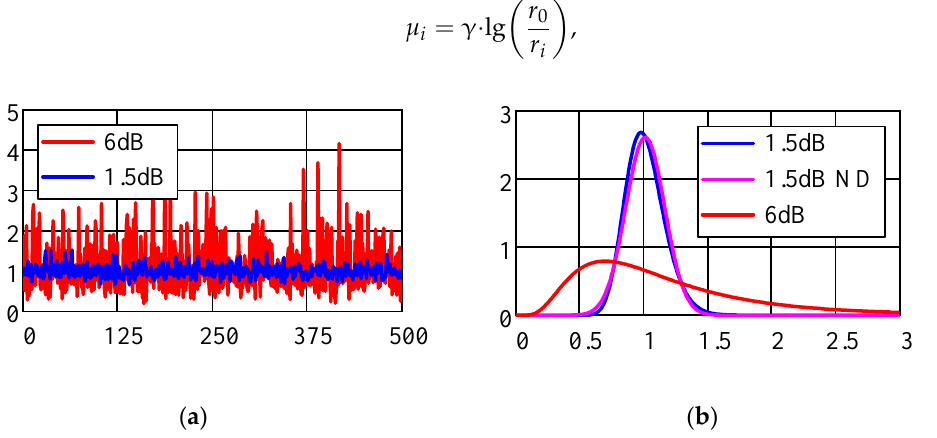
Figure 2. Change in the amplitude of the UWB signal ( a ) and the probability distribution density of the amplitude ( b ) for different values of the parameter σ P of the lognormal distribution.